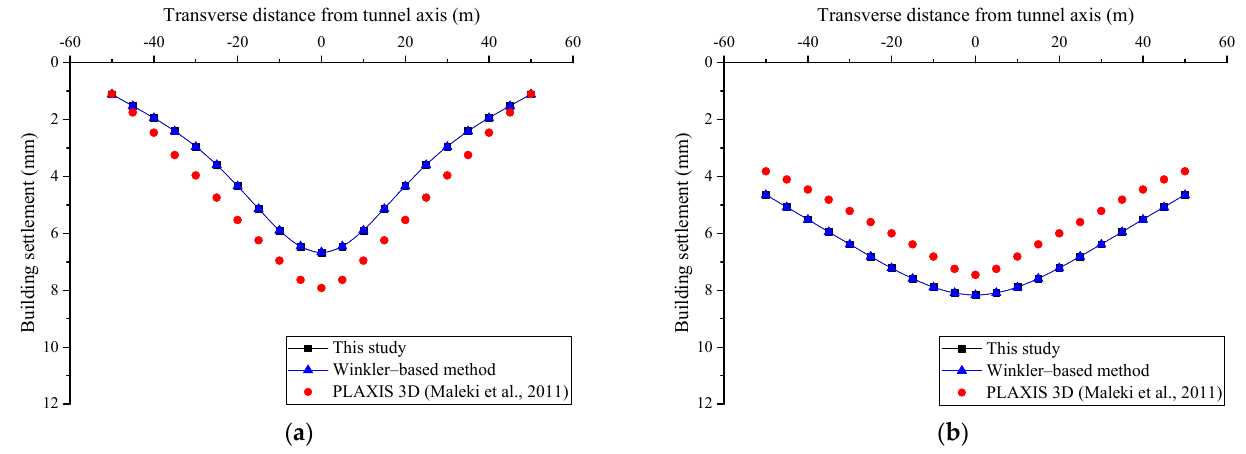
Figure 6. Comparison with building settlement from finite element method: ( a ) 4 stories; ( b ) 8 stories [17].